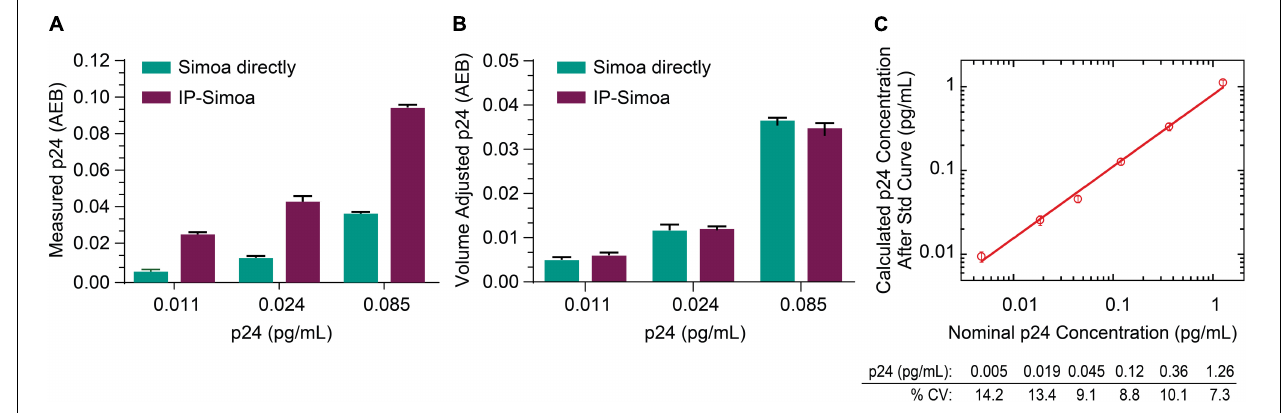
FIGURE 2 | Capture of low p24 concentrations. (A) Recombinant p24 at the lowest concentrations of the standard curve was completely recovered after IP, and (B) p24 concentration matches between direct Simoa and IP-Simoa after sample volume normalization. (C) The IP-Simoa assay’s lower limit of detection (LOD) is ≤ 0.005 pg/mL defined as the coefficient variation (CV) < 20% for each p24 standard. This would equate to 1 fg of p24 concentrated from a given volume and released into 200 µ L for